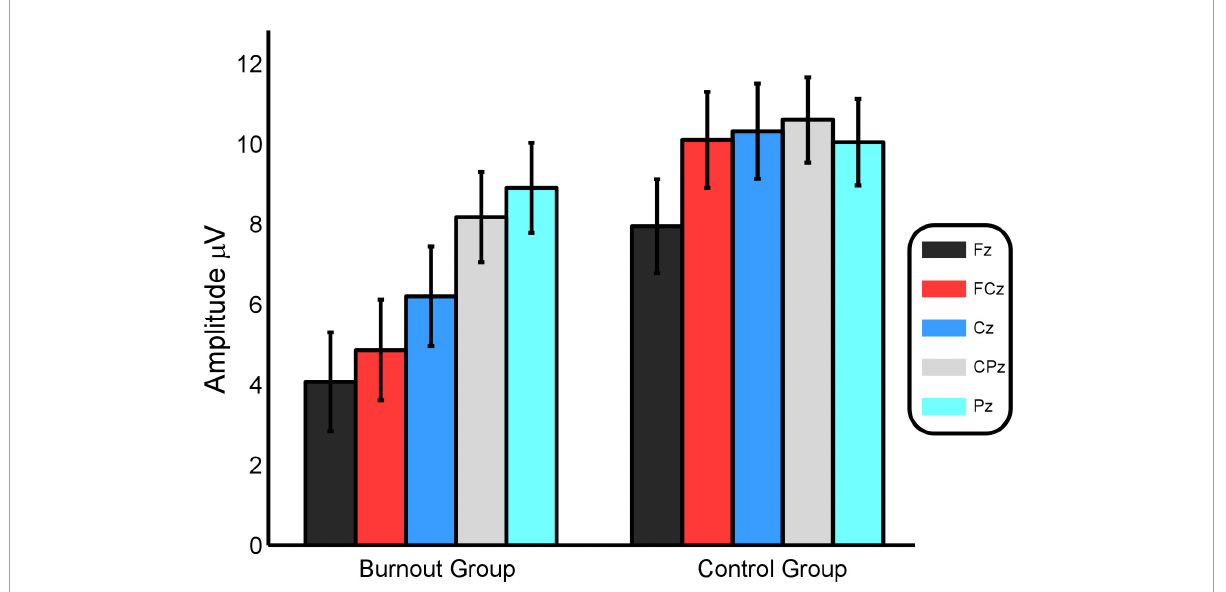
FIGURE5 A comparison of the average P3b amplitudes at the five electrode sites between the burnout group and the control group.